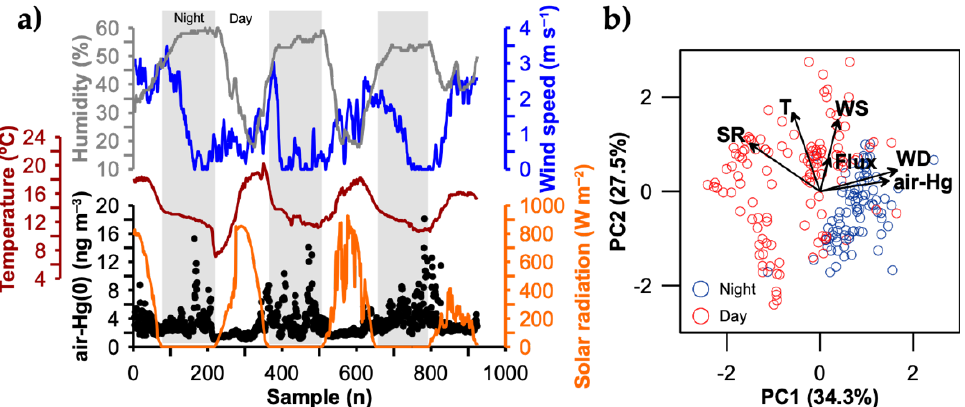
Figure 6. ( a ) Diurnal variation of air Hg(0) concentrations (ng m − 3 ) with the meteorological parameters and ( b ) principal component analysis of data obtained during the day (red circles) and night (blue circles) in the industrial site CN. Air temperature—T (°C), total incoming solar radiation—SR (W m −2 ), wind speed—WS (m s −1 ), wind direction—WD (°), the measured air Hg(0) concentrations —air-Hg (ng m −3 ) and Hg(0) flux—Flux (ng m −2 h −1 ); the grey shadow areas correspond to the nigh period.